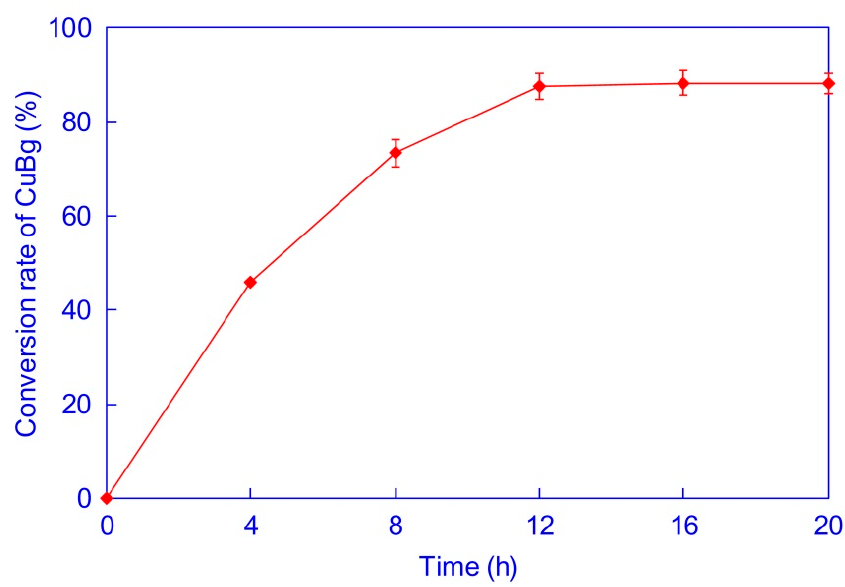
Figure 5. Time course of biotransformation of C. melo pedicel extracts using recombinant β -gluco- sidase.